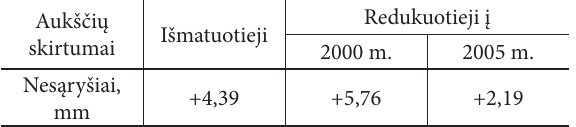
Table 2. Obtained disconnections in the polygon of Jonava –